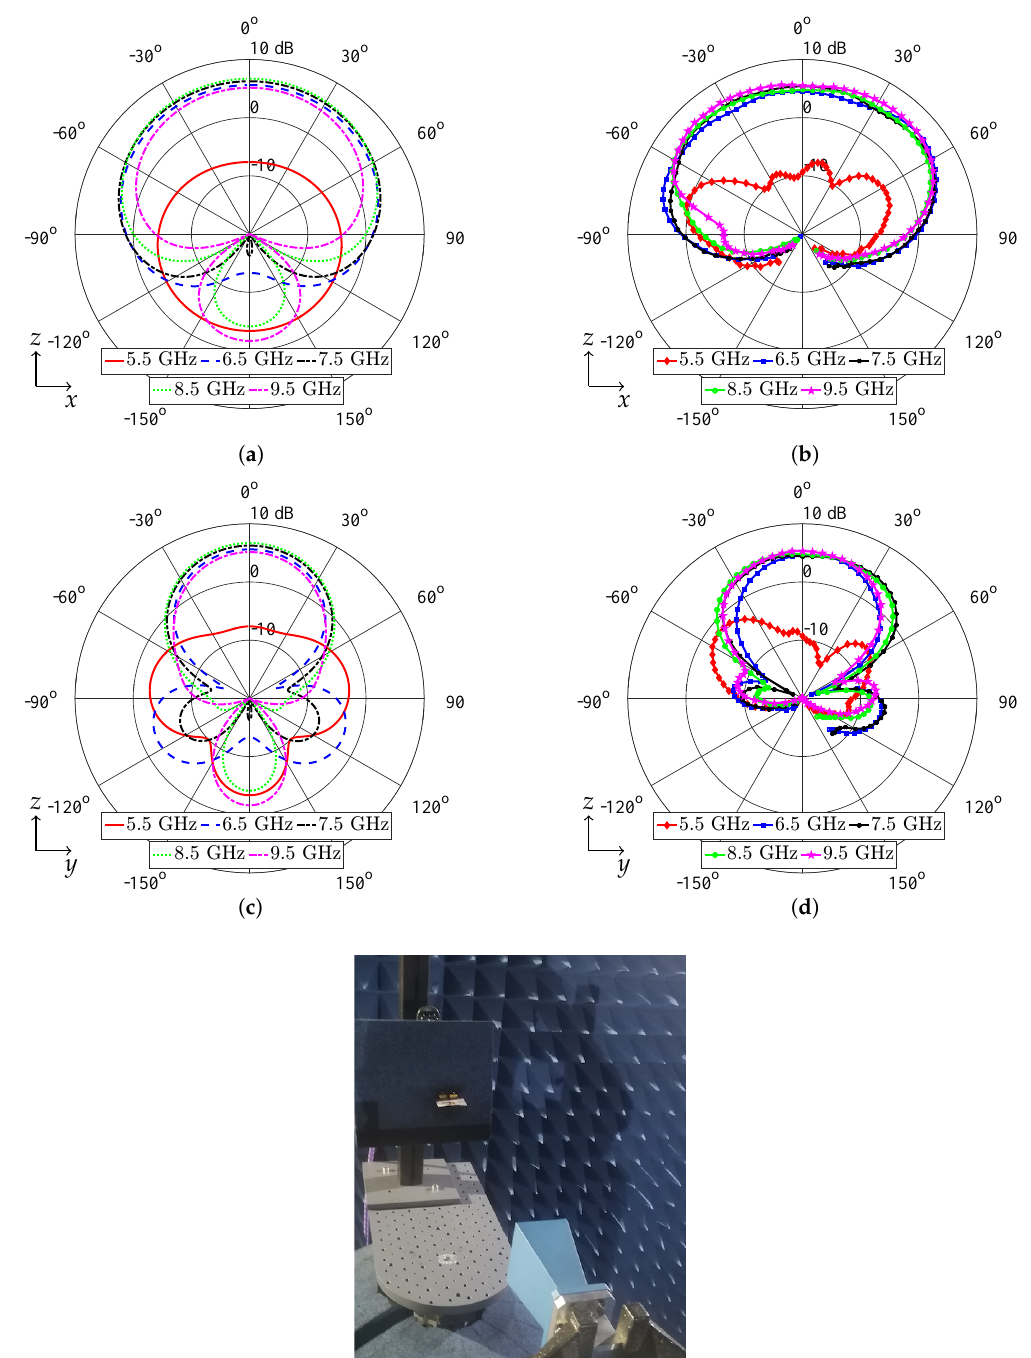
Figure 8. Antenna II: Simulated ( a ) and measured ( b ) realized gain in the xz plane ( φ = 0). Simulated ( c ) and measured ( d ) realized gain in the yz plane ( φ = 90). The maximum simulated cross-polarization level, not plotted here for brevity, is less than 54dB and 42dB for φ = 0 and φ = 90, respectively. ( e ) Setup of the antenna gain